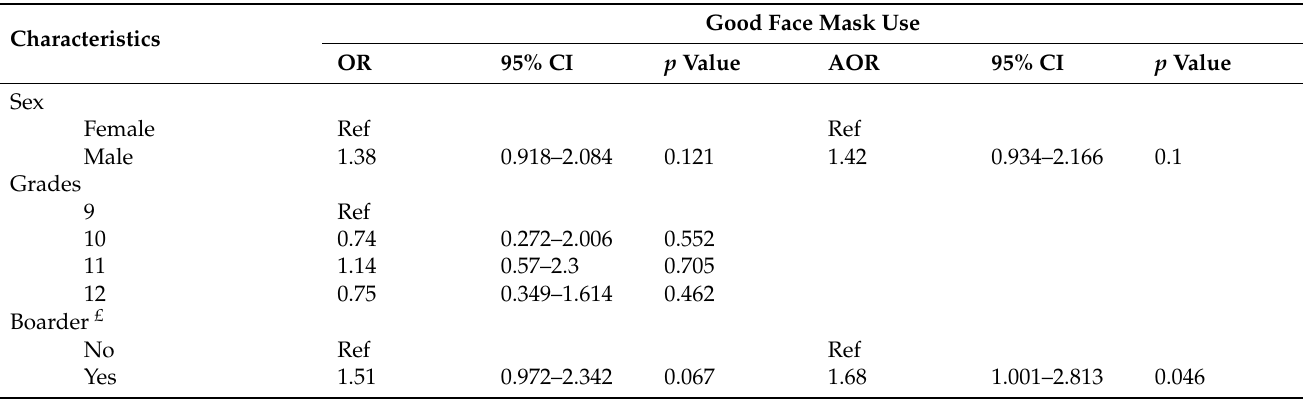
Table 3. Multivariable logistic regression of good face mask use using among the students of Mongar Higher Secondary School,